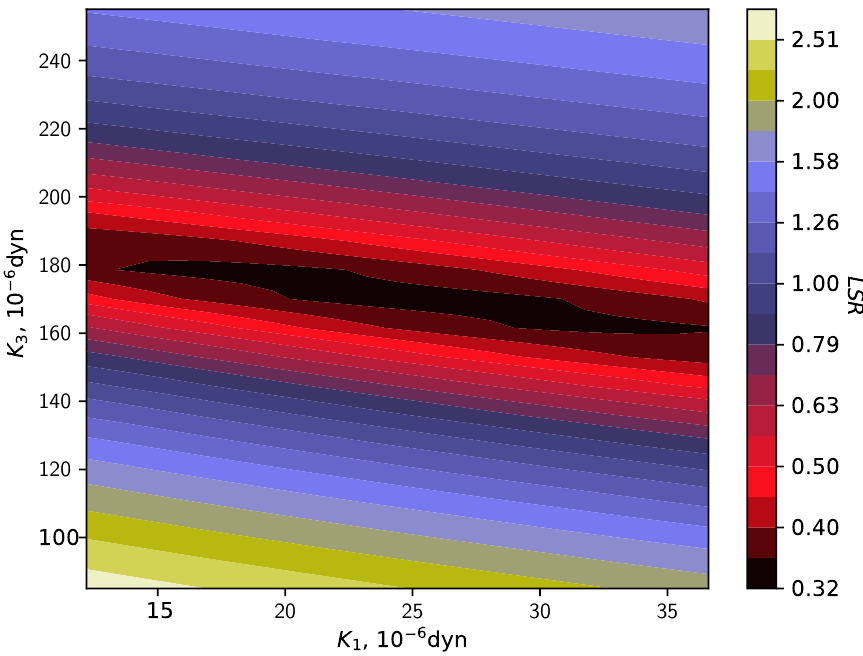
Figure 6. The map for the LSR criterion on K 1 , K 3 for Gd complex.